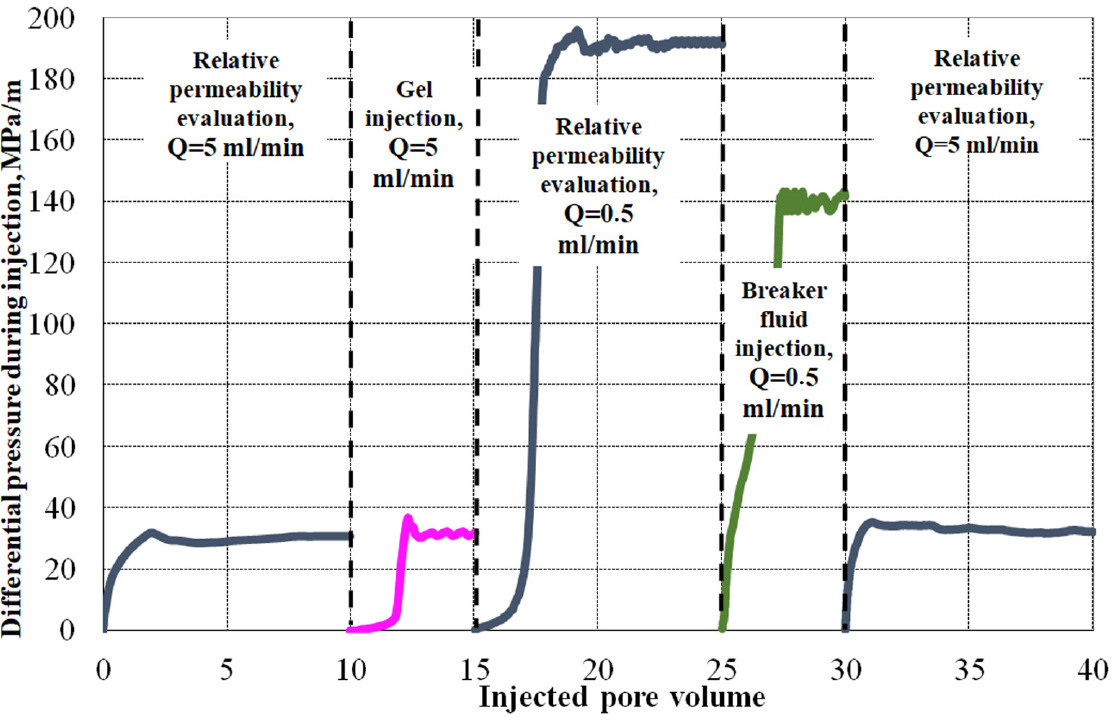
Figure 8. Correlation between the differential pressure and the injected pore volume at water-saturated fractured porous core sample. Table 4. Results of the flooding experiment on water-saturated fractured porous core sample.